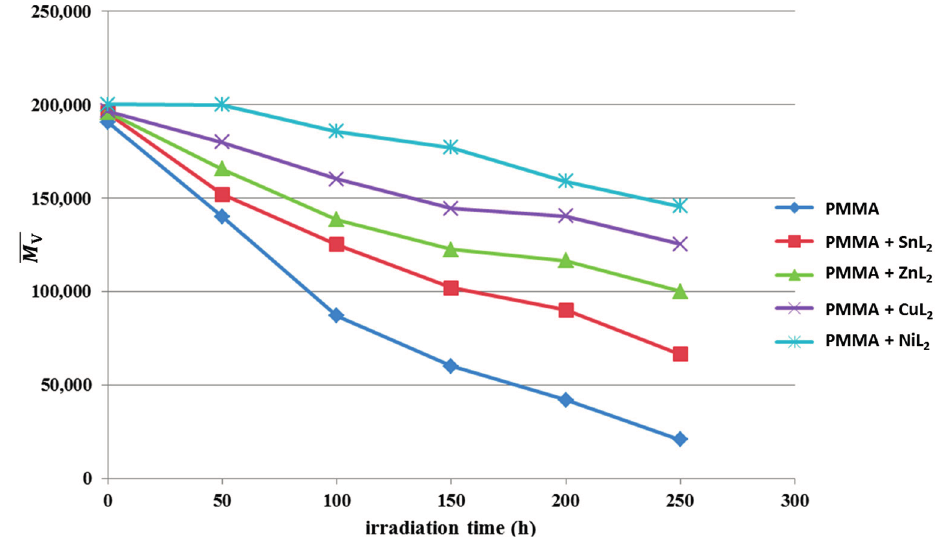
(cid:3364)(cid:3364)(cid:3364)(cid:3364)(cid:4667) during irradiation of (cid:2906)